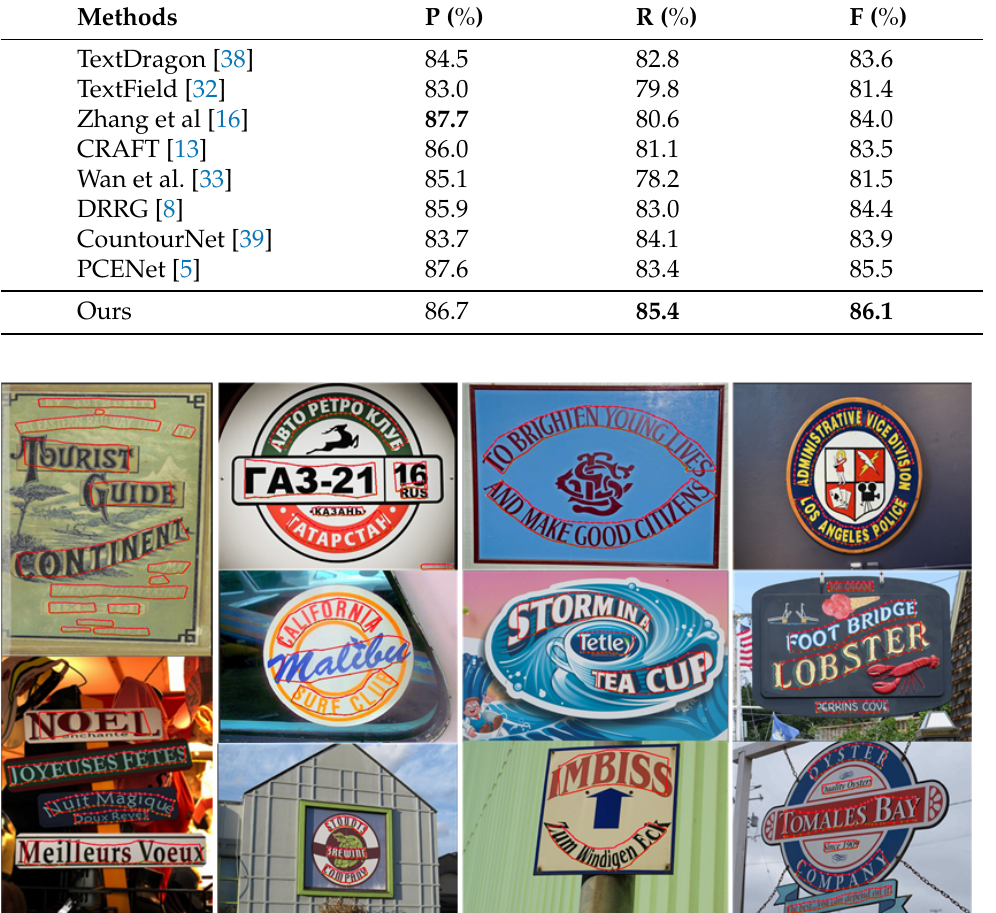
Figure 10. Detection examples produced by the proposed method on the MSRA-TD500 dataset. Discussion. The experimental results show that after adding constraints, our method can reduce the generation rate of noncharacter text, which in turn reduces the detection rate of nontext and improves the recall rate. In addition, the deep relational inference network further modifies the text regions obtained by the FPN, and the text detection effect is further improved. In addition, the deep relational inference network further corrects the text regions obtained by the FPN, and the text detection effect is further improved. However, our method is not ideal when dealing with the detection of overlapping text (Figure 11a), low-resolution text (Figure 11b), and partially occluded text (Figure 11c). The main reason for this is that the character detection effect is impacted during the detection